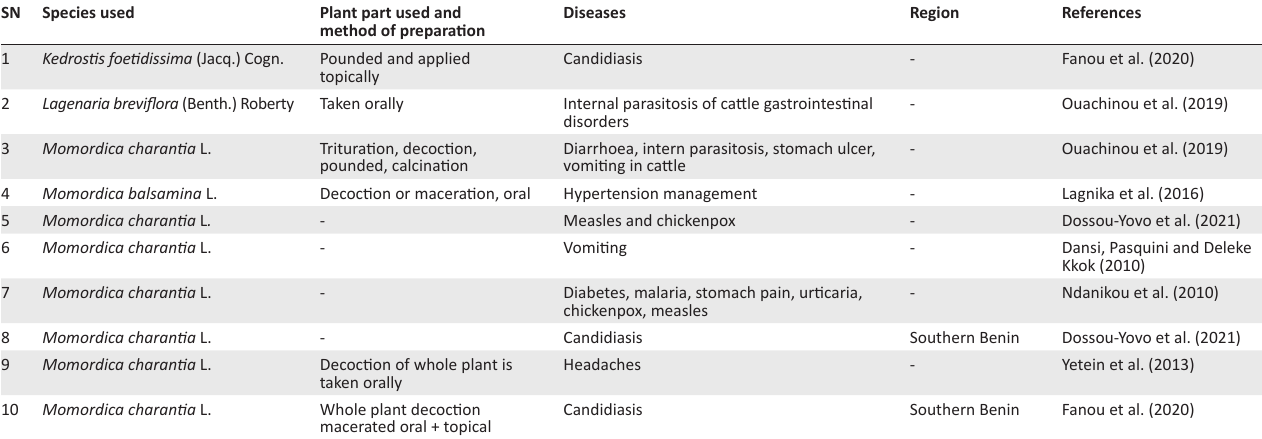
TABLE 2: Cucurbitaceae species used as traditional medicine in